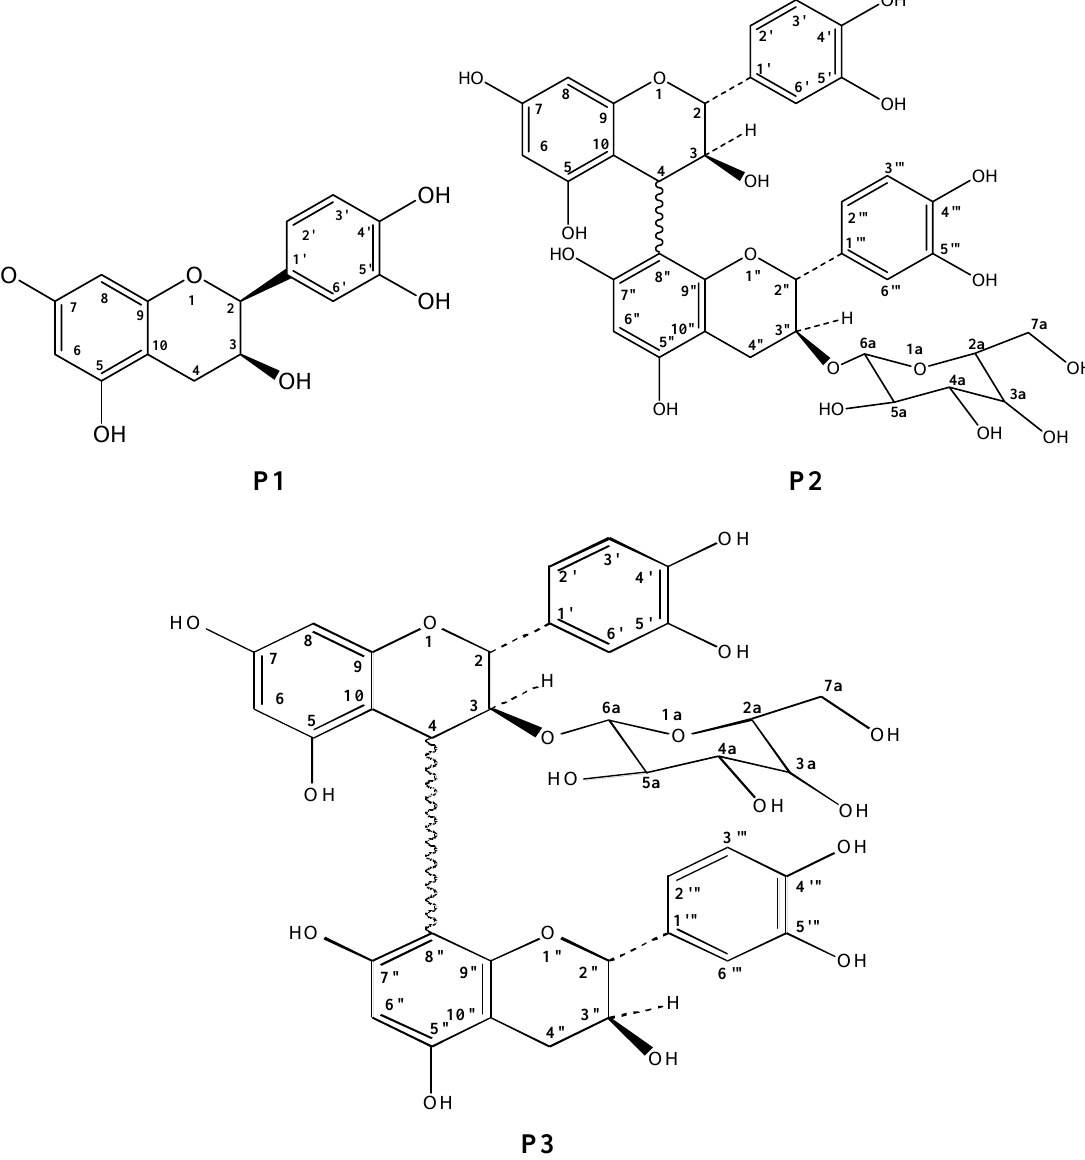
Figure 1. Chemical structure of compounds isolated from Chrysophyllum